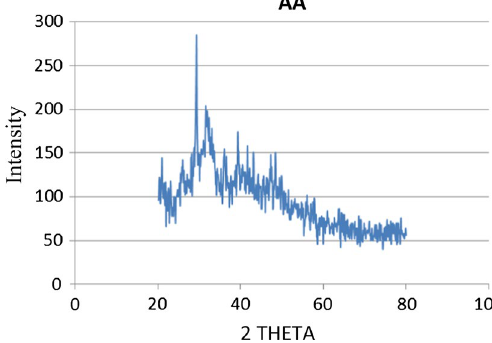
Fig. 12 XRD pattern of AEM facing anode chamber